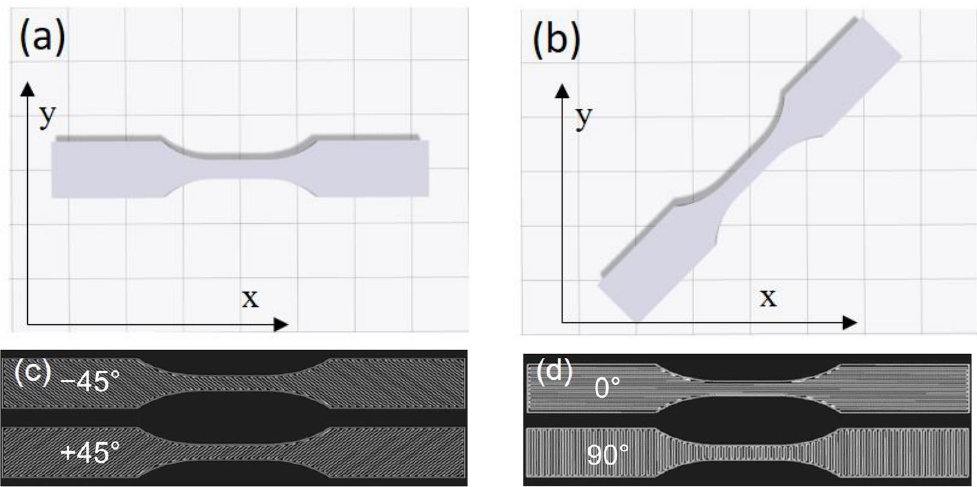
Figure 1. Schematic of sample layouts on the printing platform: ( a ) [+45, −4 5] and ( b ) [0, 90]. The raster ’ s arrangement within two consecutive layers: ( c ) [+45, −4 5] and ( d ) [0, 90].